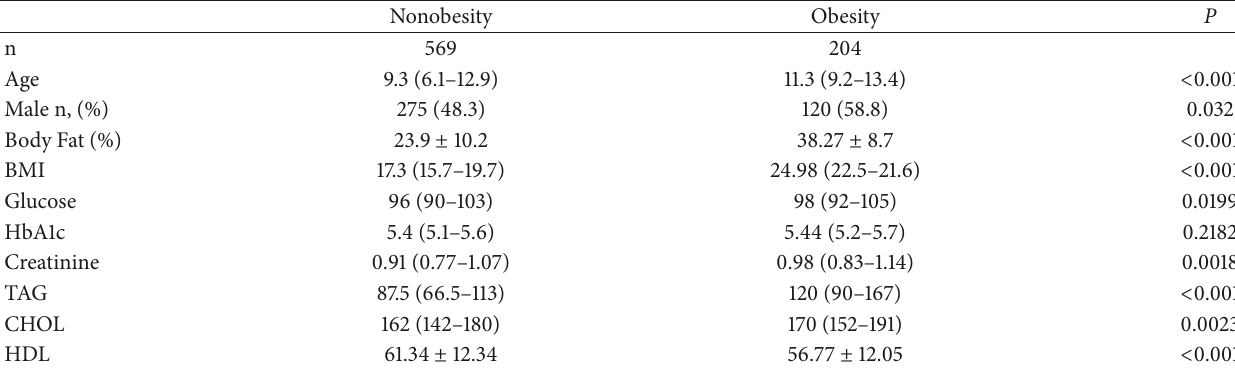
Table 2: Clinical and anthropometrical measurements according to obesity status.